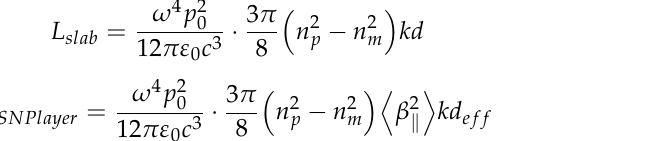
Figure 5. Emission properties of layered SNPs . ( a ) Calculated far-field emission patterns for a 1D dipole along the z-axis placed in a layer of cylindrical SNPs (blue solid lines) in a stack with different numbers of layers N, with surrounding medium n (outer left N = 1, center left N = 3, center right N = 11 with n = 1; outer right N = 11 with n = 1.5) and in an equivalent slab (red dotted lines). ( b ) Corresponding simulated near-field distributions of the dipole emission for the stack of SNPs (top row) and for the equivalent slab (bottom row).